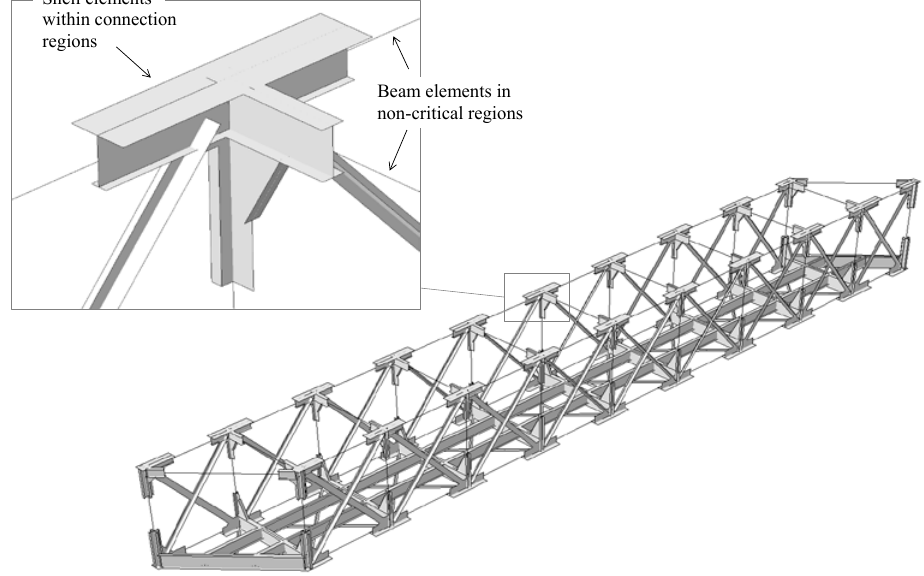
Figure 2. Bridge model element type.